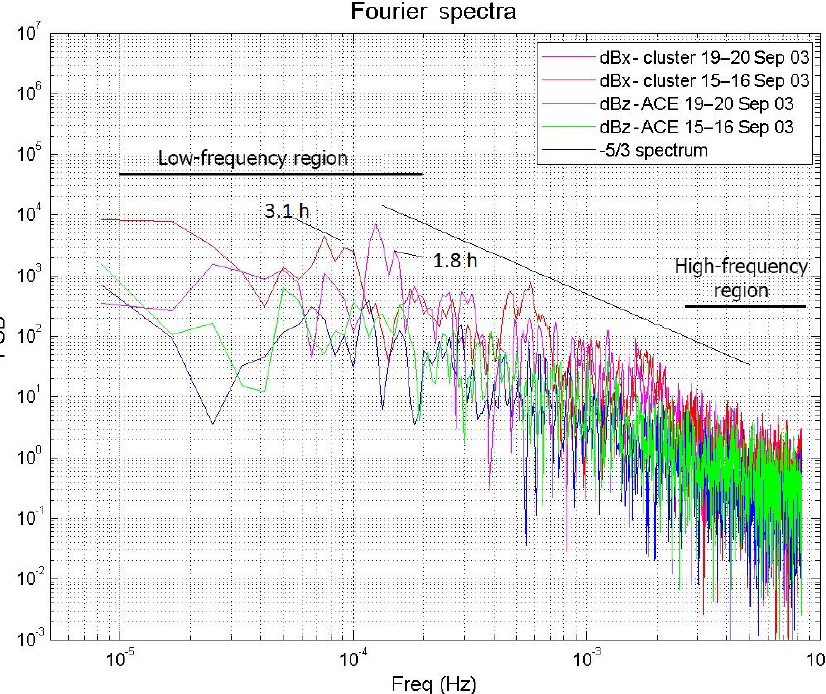
Figure 11. The Fourier spectra from ACE IMF B z and Cluster tail B x , obtained in two distinct periods, 19 to 20 September and 15 to 16 October 2003. The black line represents the Kolmogorov’s power-law scale of − 5 / 3. PSD stands for power spectral